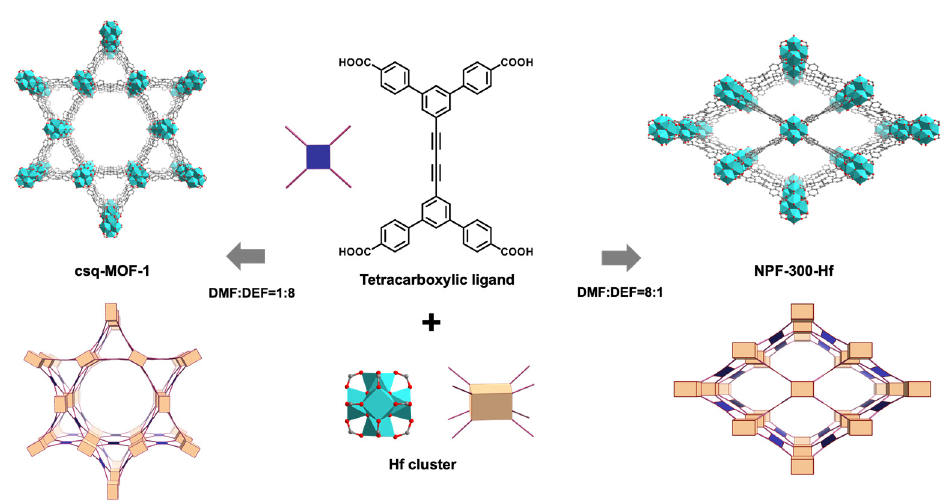
Figure 1. Synthesis, structure, and topological representation of csq-MOF-1 in comparison with NPF-300 (Hf).